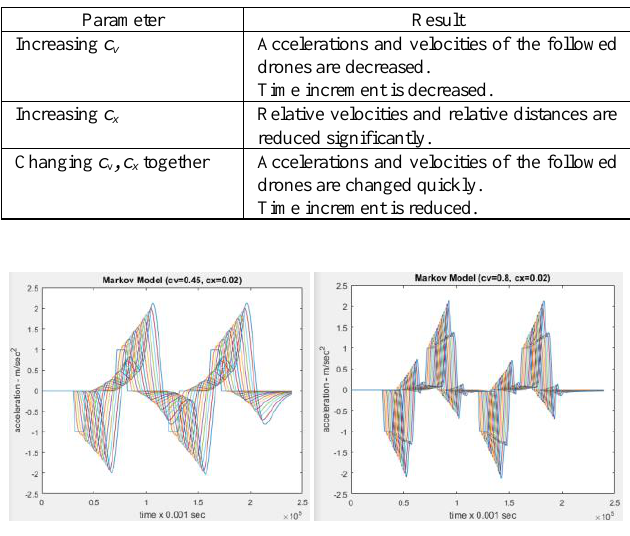
Fig. 13. The impact of Markov model parameters on the accelerations.